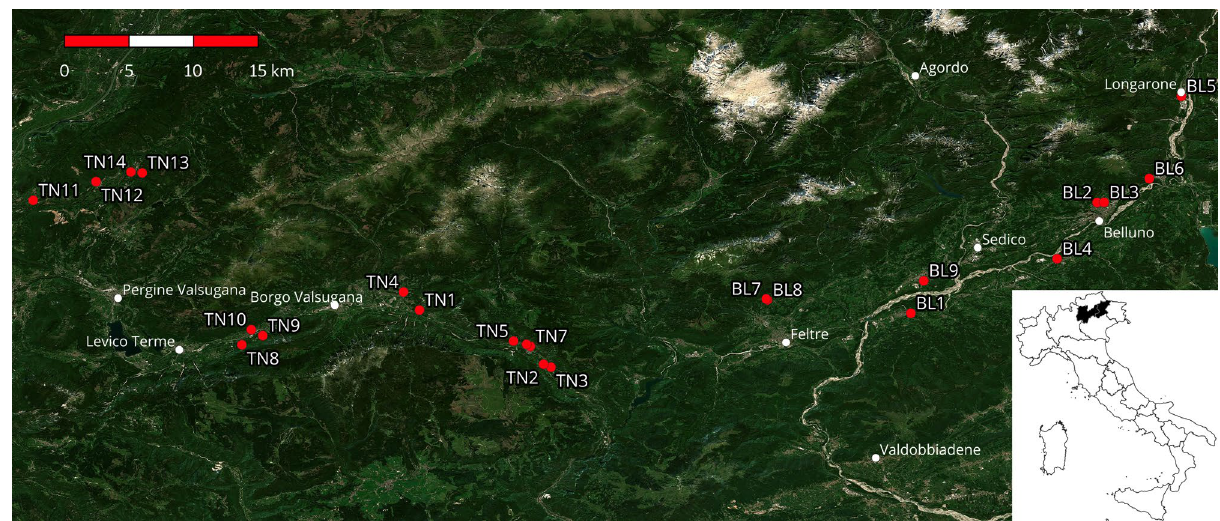
Figure 2. Study area. Points represent the sampling sites marked with the ID number as in Tables 2 and 3. Background satellite image from Sentinel-2 cloudless (https:// s2maps. eu), and urban places from OpenStreetMap contributors (https:// opens treet map. org). Map created using QGIS